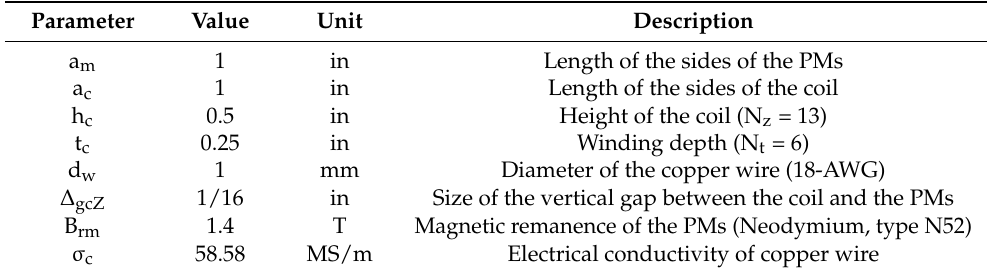
Figure 5. FE model used for validation of the force-current model developed in this study: ( a ) longitudinal cross section on the XZ-Plane, ( b ) XY-Plane, ( c ) FE model enclosed by the air domain; and ( d ) B mt -field on the XZ-plane at Y = 0 for u sX = − 0.216a c and I ci = − 0.849 A. Table 1. Geometrical and material parameters of the coil and PMs in the FE model developed in COMSOL Multiphysics